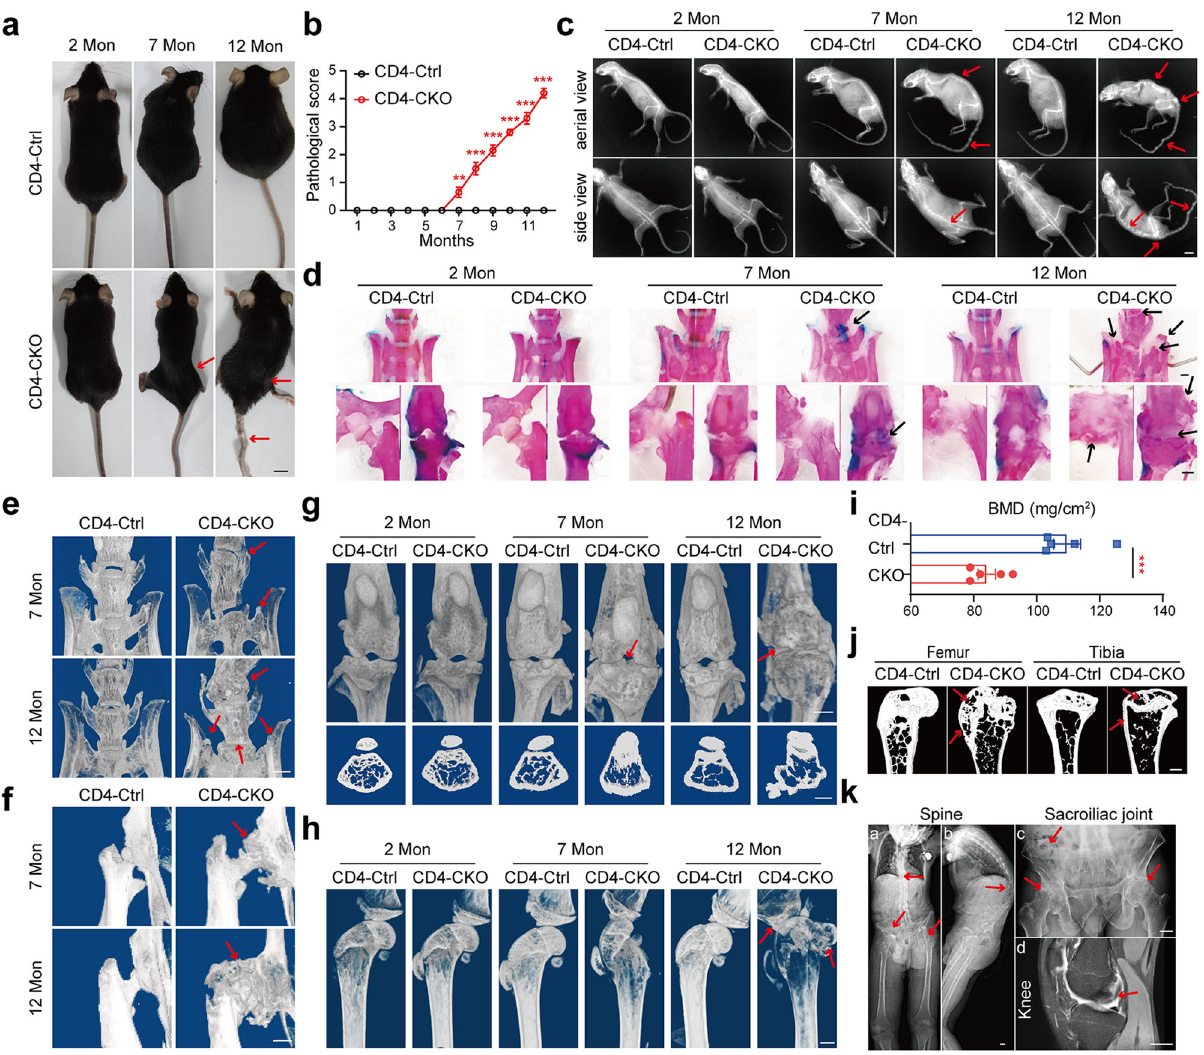
Fig. 1 Ptpn11 deletion in CD4-expressing cells causes age-related AS-like bone disease. a Gross images of female mice. b Pathological scores ( n = 10). c X ‐ ray images of female mice. Red arrows show kyphosis and joint ankylosis in mature and aged CD4-CKO mice. a , c Scale bars: 1 cm. d Skeleton staining results indicate increased Alcian blue staining (cartilage) in mature CD4-CKO mice and bone fusion in aged CD4-CKO mice. Black arrows show bone deformation. e – h μ -CT radiographs show bone structure of sacroiliac joints, spines ( e ), hip joints, ( f ) and knee ( g , h ). Arrows show osteophytes and bony fusion in spine, hip joints and knee joints. i Femoral bone mineral density (BMD) ( n = 5) and j Sagittal sections of femur and tibia show decreased BMD and loss of cortical bone and subchondral bone in aged female CD4-CKO mice. Arrows show bone loss. d – h , j Scale bars: 1 mm. k Radiological images of patients with AS. Arrows indicate outward acetabular labrum, ankylosis of hip and sacroiliac joints and abnormity of epiphysis respectively. Scale bars: 2.5 cm. b , i Data are presented as mean ± SEM. b ** p < 0.01, *** p < 0.001, i p -value = 0.0010, determined by two-tailed Student ’ s t -test. a , c – h , j , k Data are representative of three independent biological